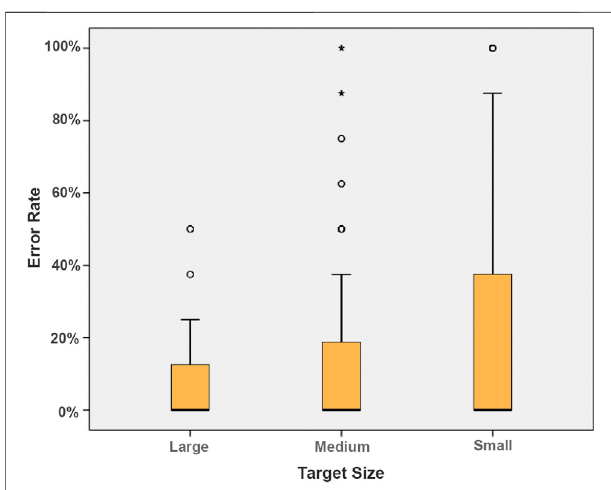
FIGURE 6 | Mean error rate with different target sizes.